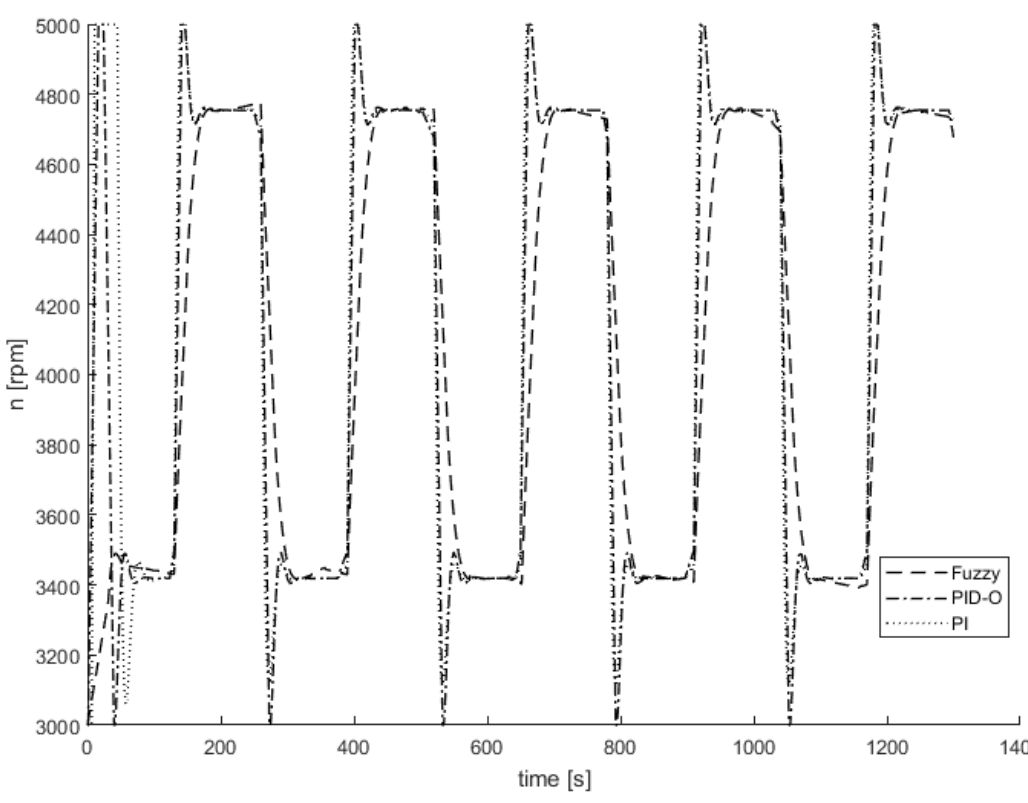
Figure 15. Comparison of control methods—Qair.